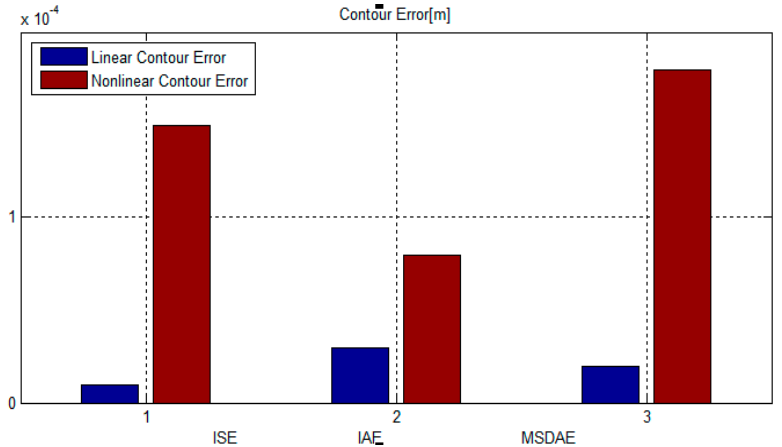
Figure 4. Fitness functions vs. iteration number for non-linear contour.